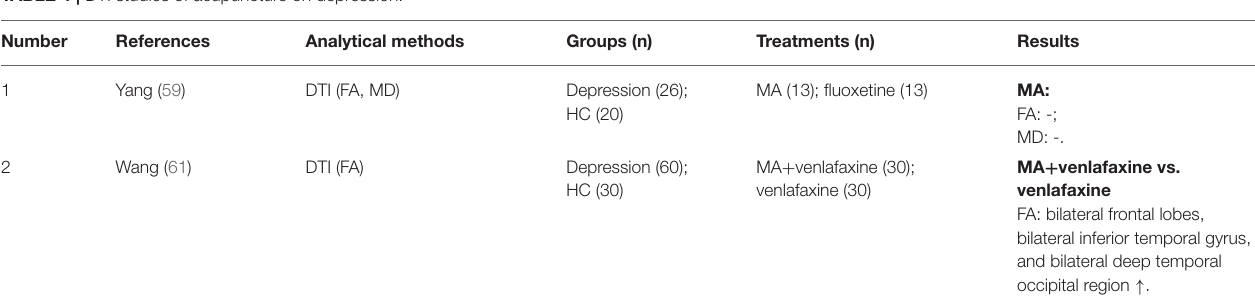
TABLE 4 | DTI studies of acupuncture on depression.